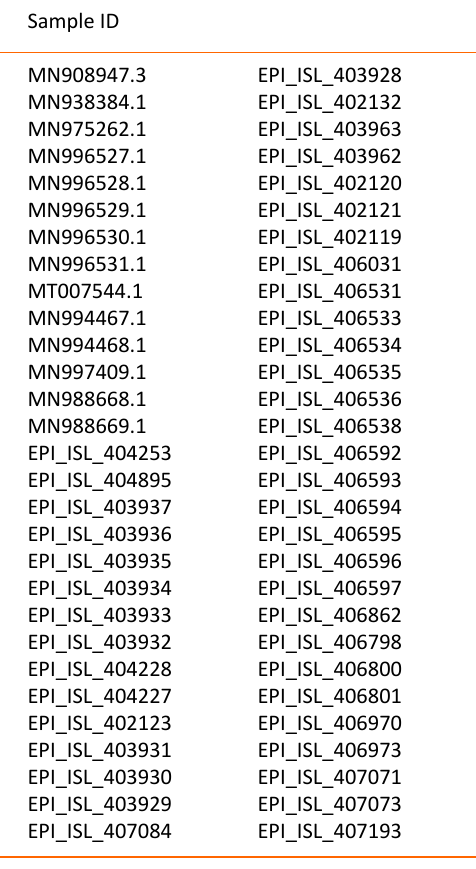
Table 1. SARS-CoV-2 isolates from the biological databases (GISAID and NCBI).